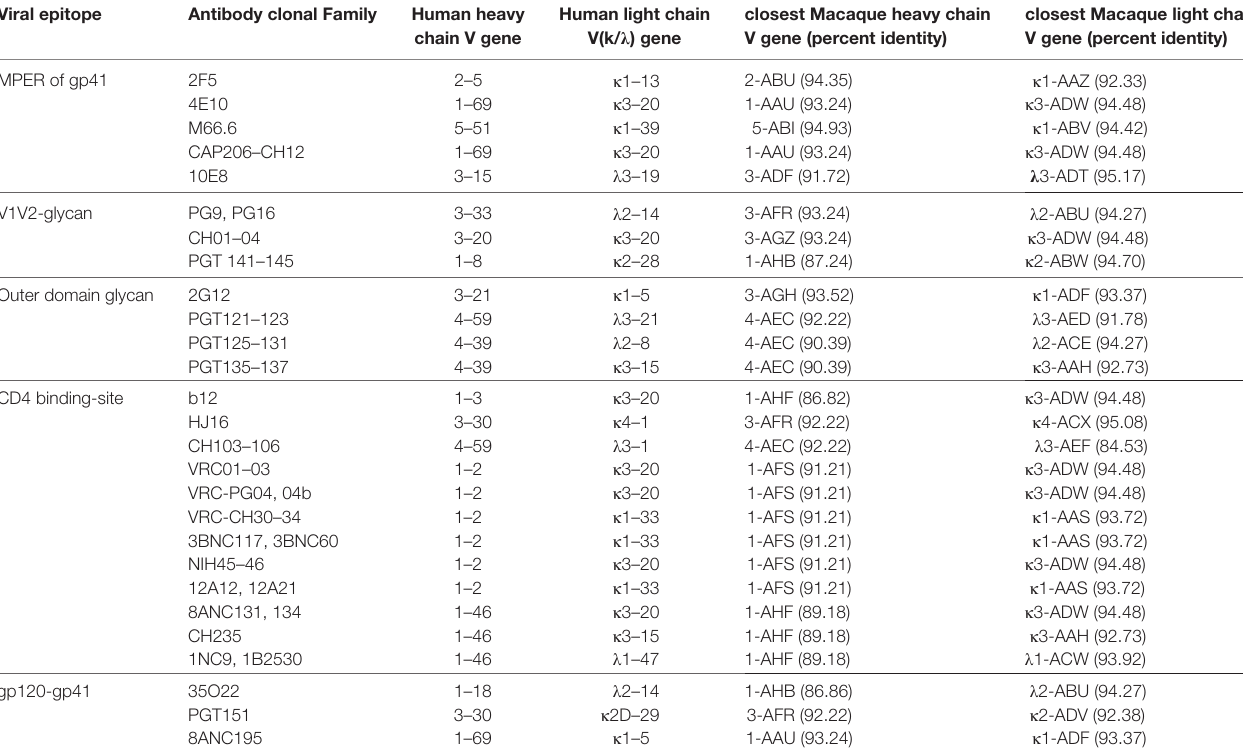
TaBle 6 | Heavy and light chain V gene usage in human neutralizing and broadly neutralizing bodies with the corresponding closest macaque V genes. Viral epitope antibody clonal Family